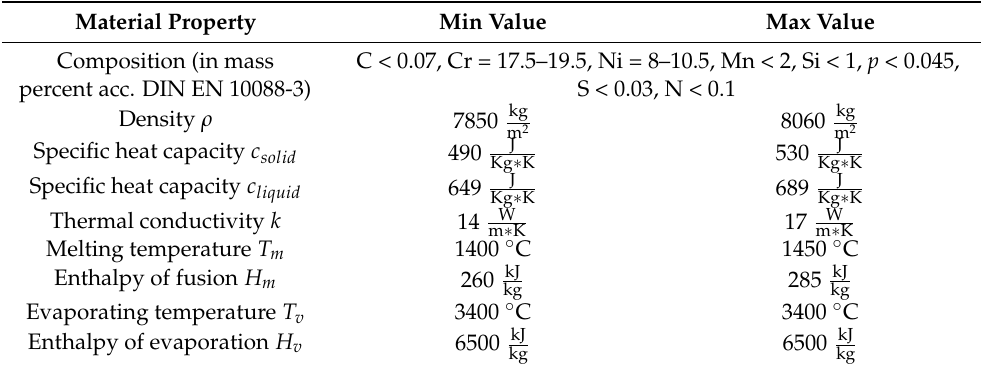
Table 1. The material properties of stainless steel 1.4301 (X5CrNi18-10)